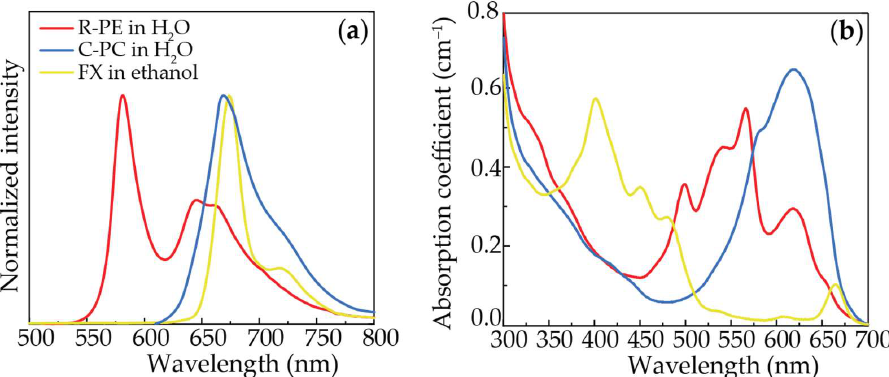
Figure 3. ( a ) Emission upon excitation at 488, 590, and 410 nm, respectively, and ( b ) absorption spectra of the bio-molecules R-PE, C-PC, and FX in solution.